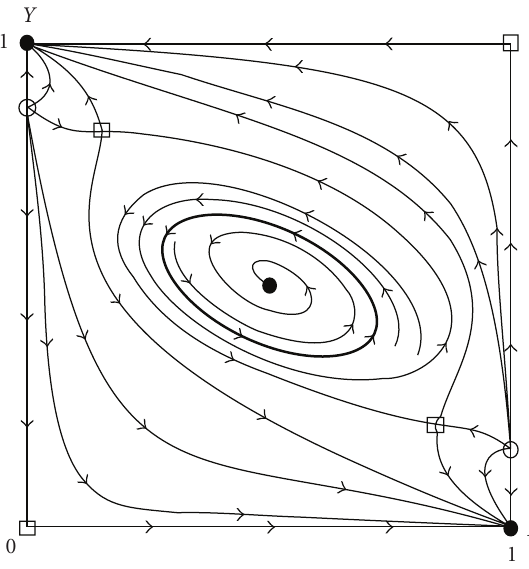
Figure 5.2 . Two interior saddles and one interior attractor surrounded by a repelling limit cycle.